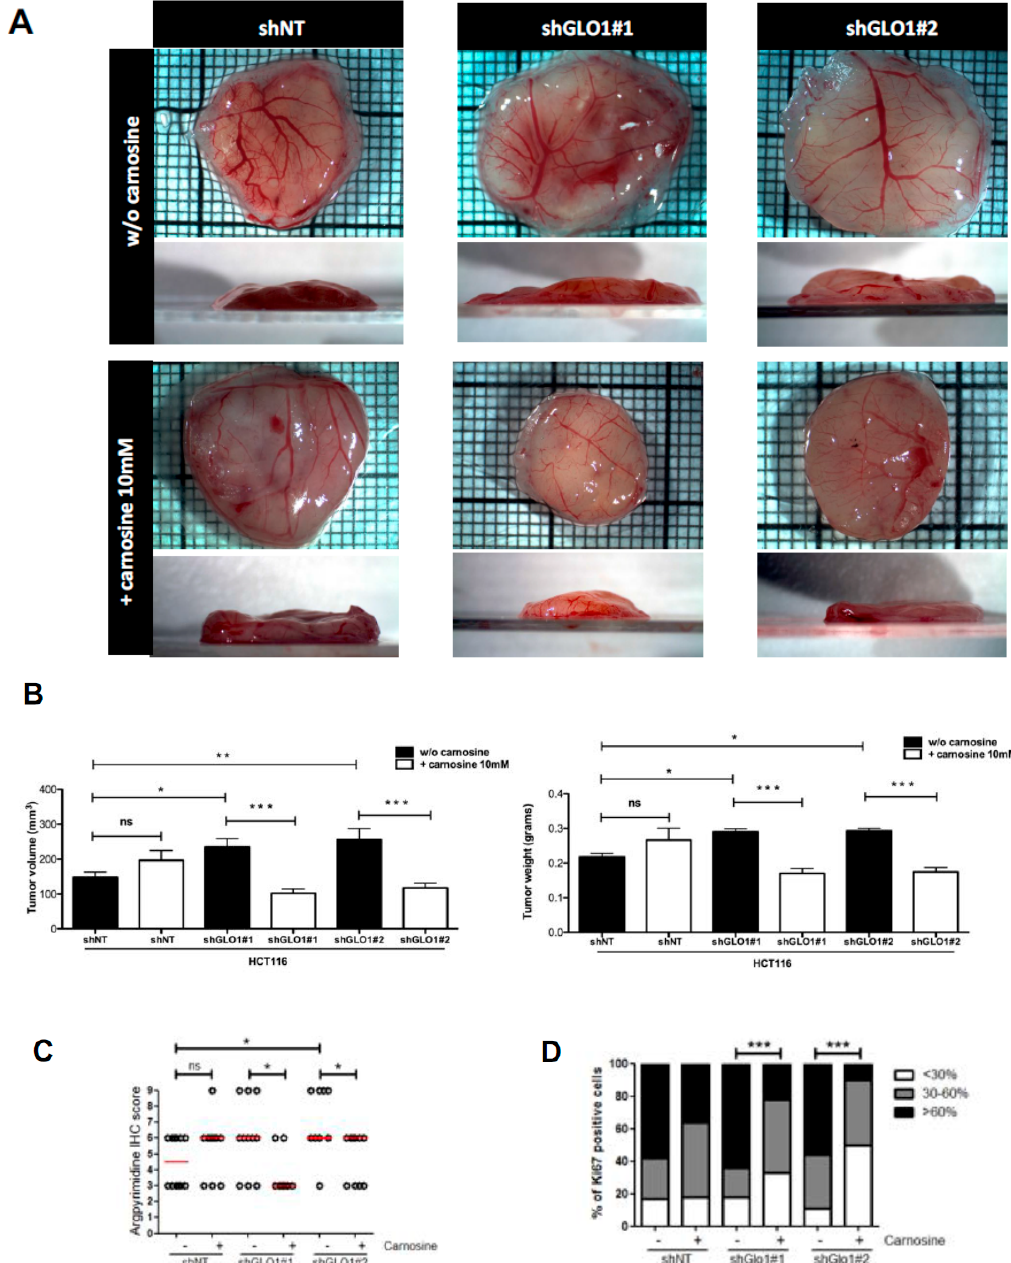
Figure 6. Carnosine treatment of GLO1 -depleted HCT116 cells inhibits tumor growth in vivo. HCT116 shGLO1#1 and #2 and shNT control cells were implanted on chorioallantoic (CAM) tumor model. Cancer cells were treated with carnosine (10 mM) from the day after implantation on CAM until the end of the experiment. Tumor growth has been evaluated seven days post-implantation (at least 10 eggs/group) as described under Material and Methods section. ( A ) Representative macroscopic tumor appearance in each condition is shown; ( B ) Reduction of tumor volume ( left panel ) and weight ( right panel ) after carnosine treatment of GLO1 depleted HCT116-derived tumors, data are shown as mean values ± SEM. Statistical analysis has been performed using Bonferroni Multiple Comparison Test; ( C ) Significant decrease of argpyrimidine level in experimental CAM tumors upon carnosine treatment. Each dot represents one case and bars represent median. Statistical analysis has been performed using Dunn’s Multiple Comparison Test and Mann–Whitney test; ( D ) Percentage of Ki67 positive cells in experimental CAM tumors upon carnosine treatment. Statistical analysis has been performed using Chi-square Contingency Test. * p < 0.05, ** p < 0.01, *** p < 0.001, and ns = not significant.